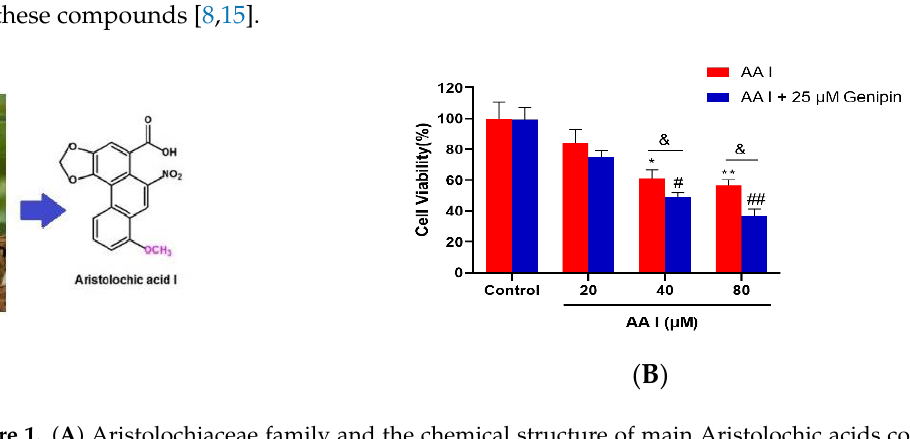
Figure 1. ( A ) Aristolochiaceae family and the chemical structure of main Aristolochic acids com- ponents AA I. ( B ) Toxicity of AA I to HK-2 cells. MTT was used for cell viability and cytotoxicity. HK-2 cells were treated with different concentrations of AA I with or without genipin for 24 h. All the experiments were repeated at least three times, and the data were expressed as means ± SD (* p < 0.05; ** p < 0.01 vs. AA I Control group; # p < 0.05; ## p < 0.01 vs. AA I + 25 µ M Genipin Control group; & p <